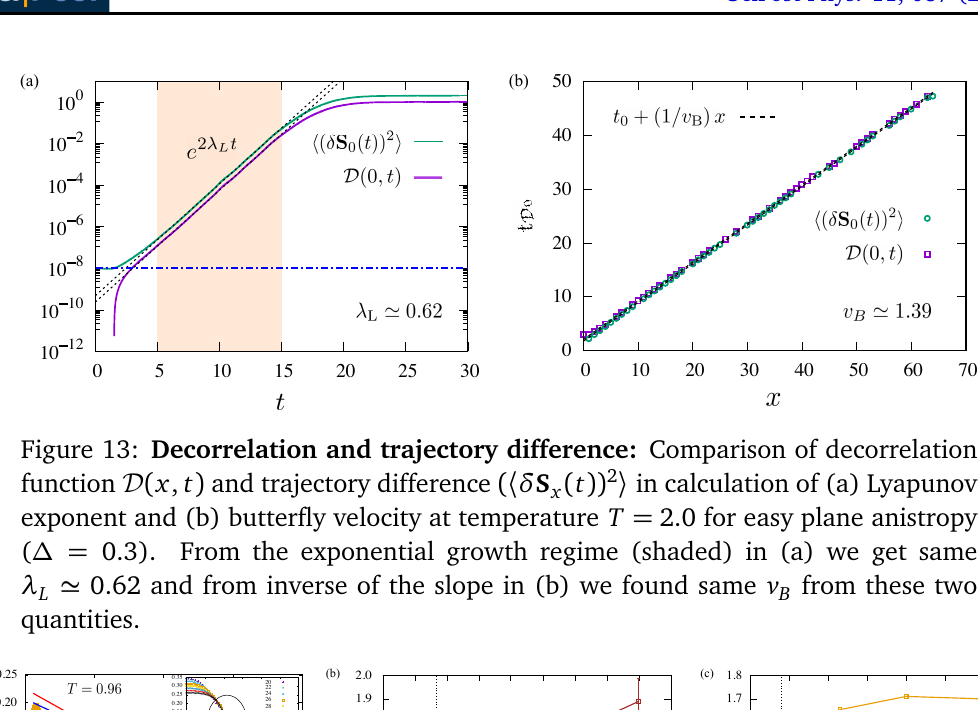
( t )) 2 〉 in calculation of (a) Lyapunov x from these two B